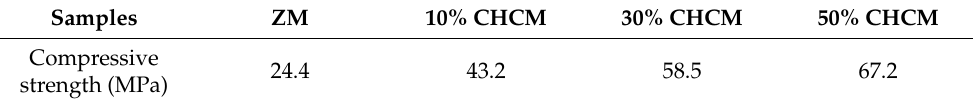
Table 2. Comparison of compressive strength of ZM and CHCM samples with different deformations.